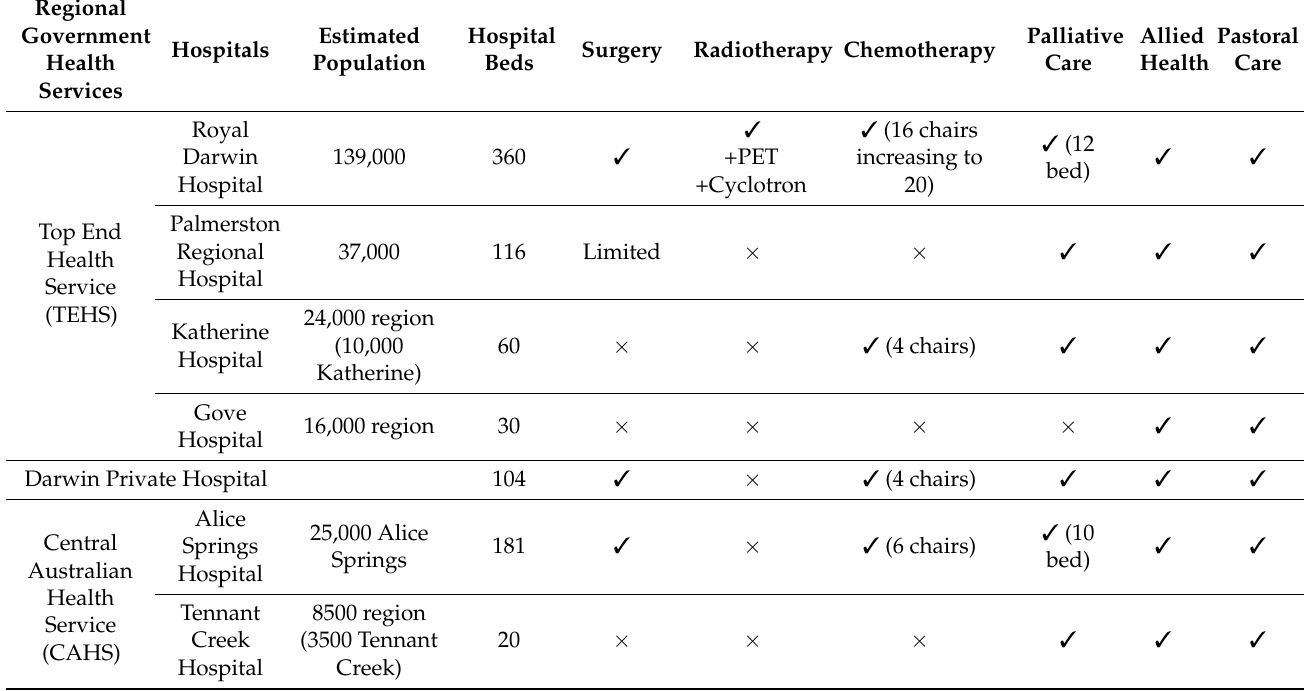
Table 1. NT Health and Cancer Services, 2022